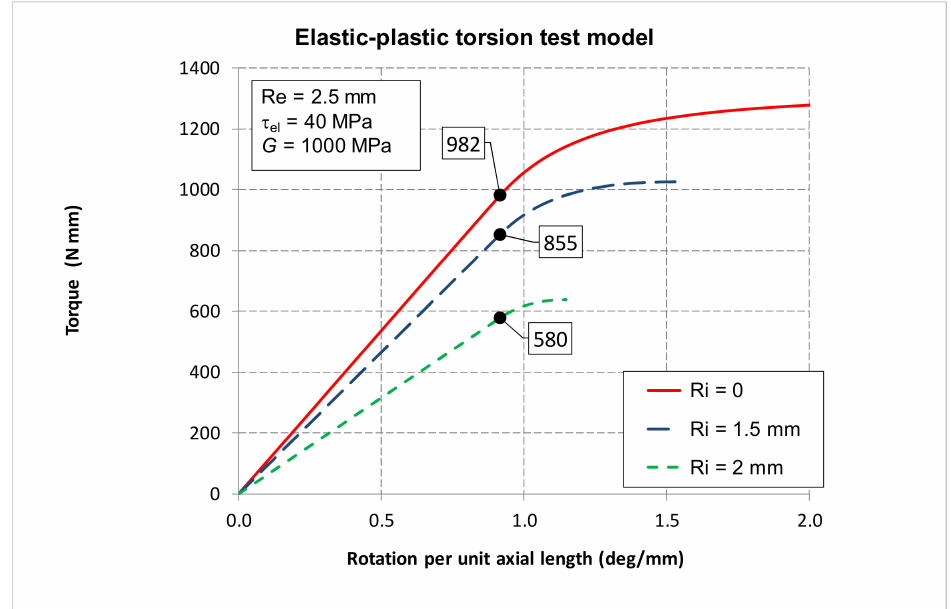
Figure 6. Modelling the effect of the internal radius on torsion tests